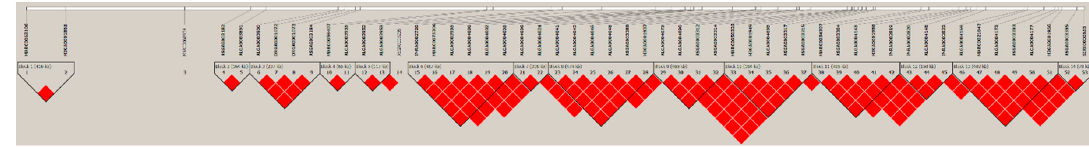
Figure 3. Linkage disequilibrium (LD) pattern for 53 significant SNPs on chromosome one. Note: the solid line triangle indicates LD. One square indicates LD level (r 2 ) between two SNPs, and the squares are colored by the D’ & LLOR standard scheme. D’ & LLOR standard scheme is that red indicates LLOR > 2, D’ = 1; pink indicates LLOR > 2, D’ < 1; blue indicates LLOR < 2, D’ = 1; and white indicates LLOR < 2, D’ < 1. LLOR is the logarithm of likelihood odds ratio and the reliable index to measure D’.